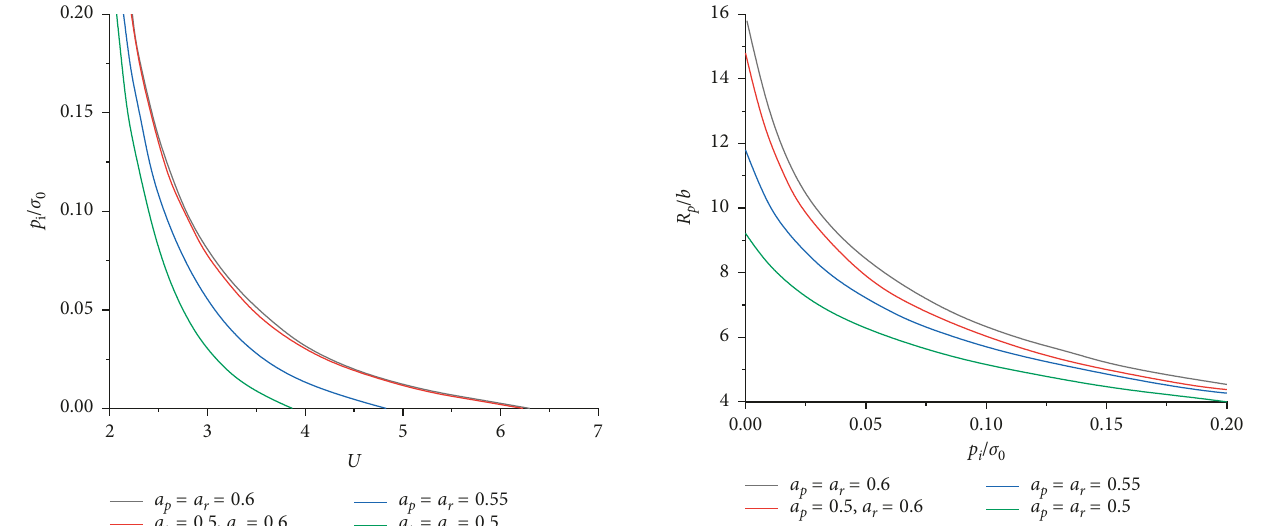
Figure 24: Ground reaction curves for different a for the gener- alized H-B rock mass.